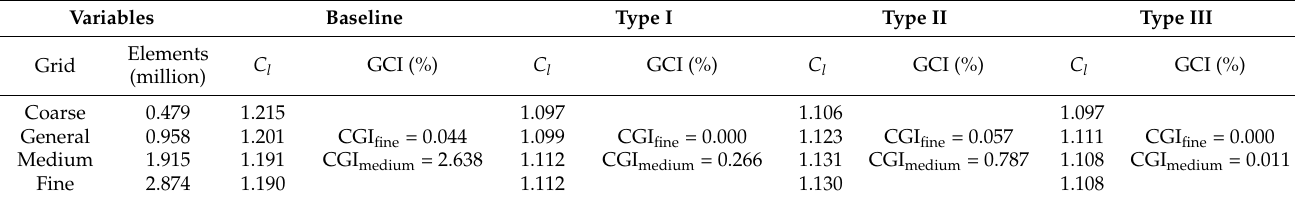
Table 1. Numerical uncertainty evaluation based on the GCI indexes.